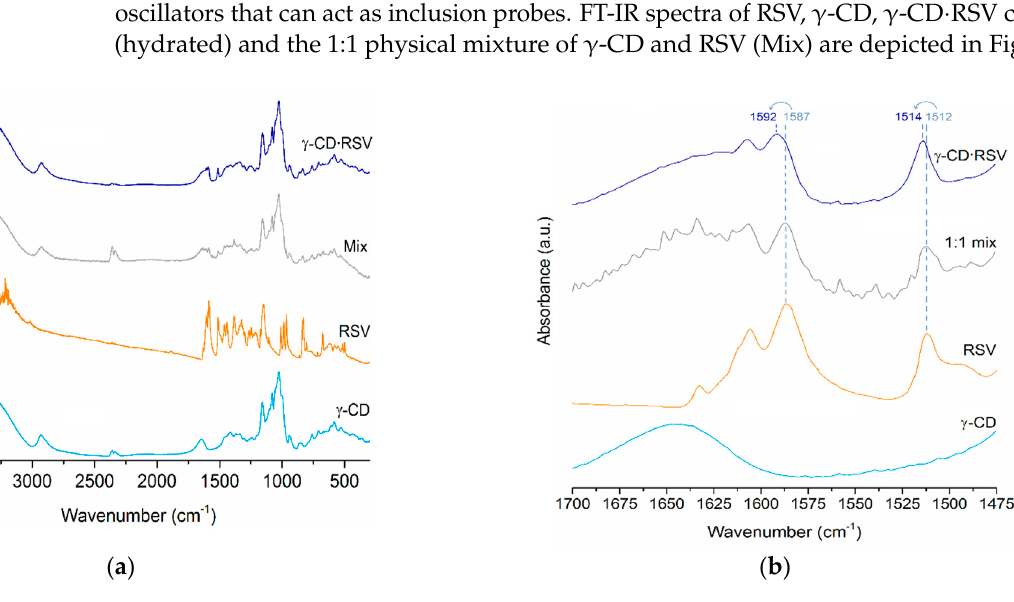
Figure 1. ( a ) FTIR spectra of gamma-cyclodextrin ( γ -CD) (light blue), resveratrol (RSV) (orange), physical mixture (Mix, grey) and γ -CD · RSV hydrated complex (dark blue). The inset, ( b ), represents a selected spectral window where some guest bands are visible in γ -CD · RSV (dark blue), with highlight to those at 1592 and 1514 cm − 1 that are blueshifted in regard to the same bands of pure RSV (orange) and 1:1 mix (grey), occurring at 1587 and 1512 cm − 1 ; γ -CD (light blue).